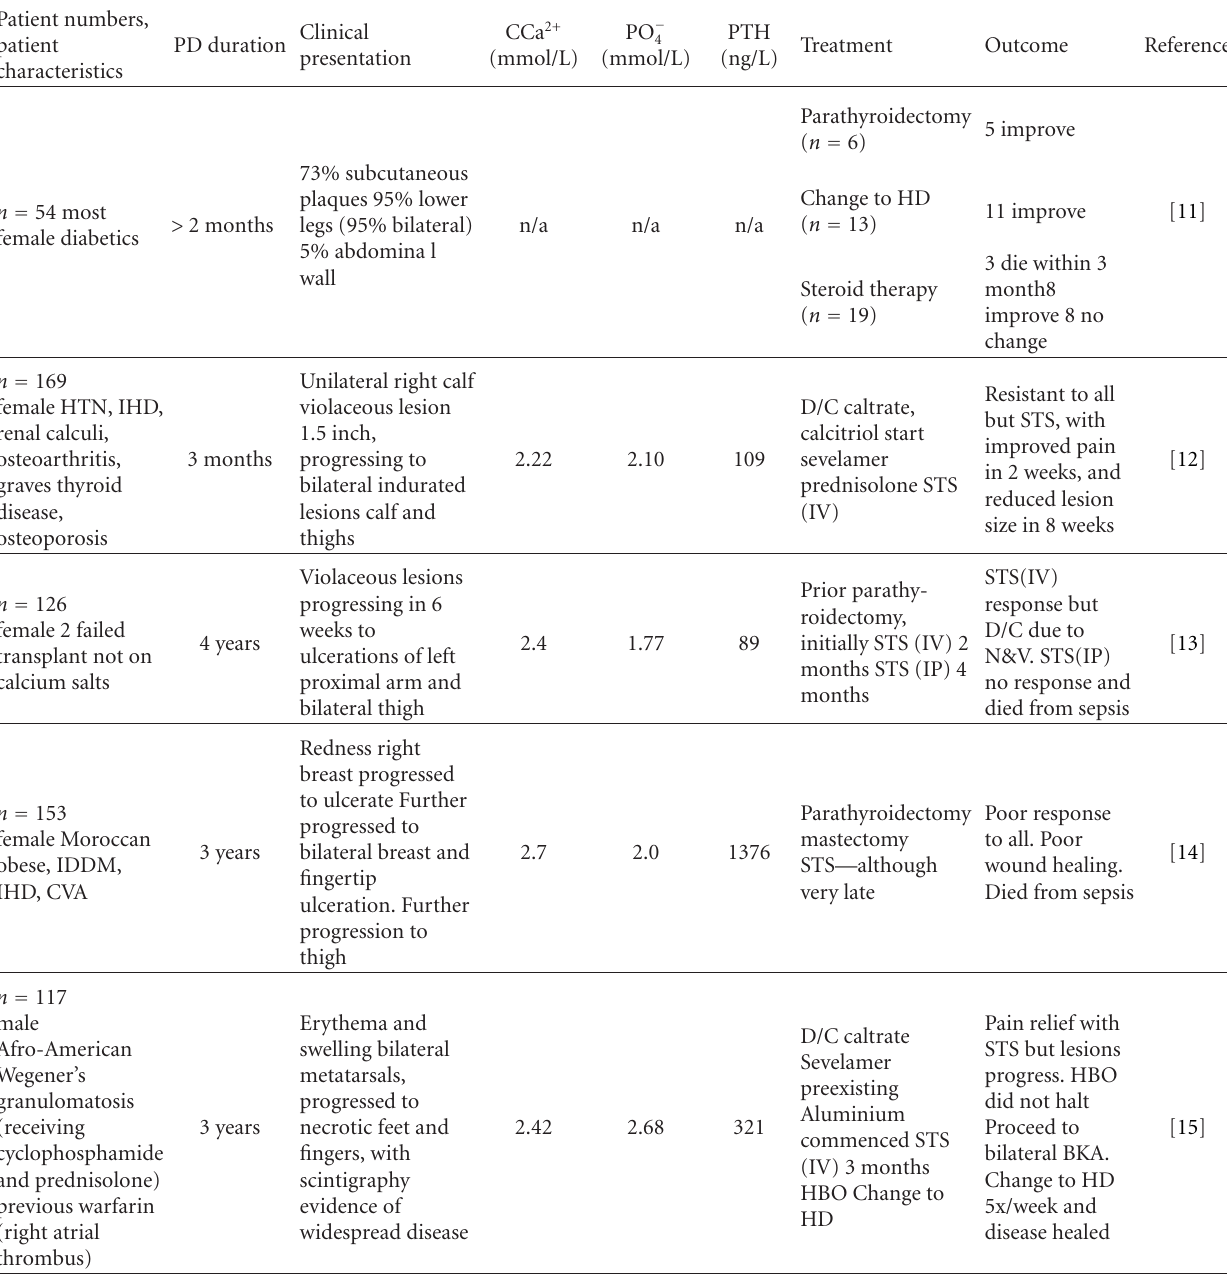
Table 1: CUA cases in PD population described within the